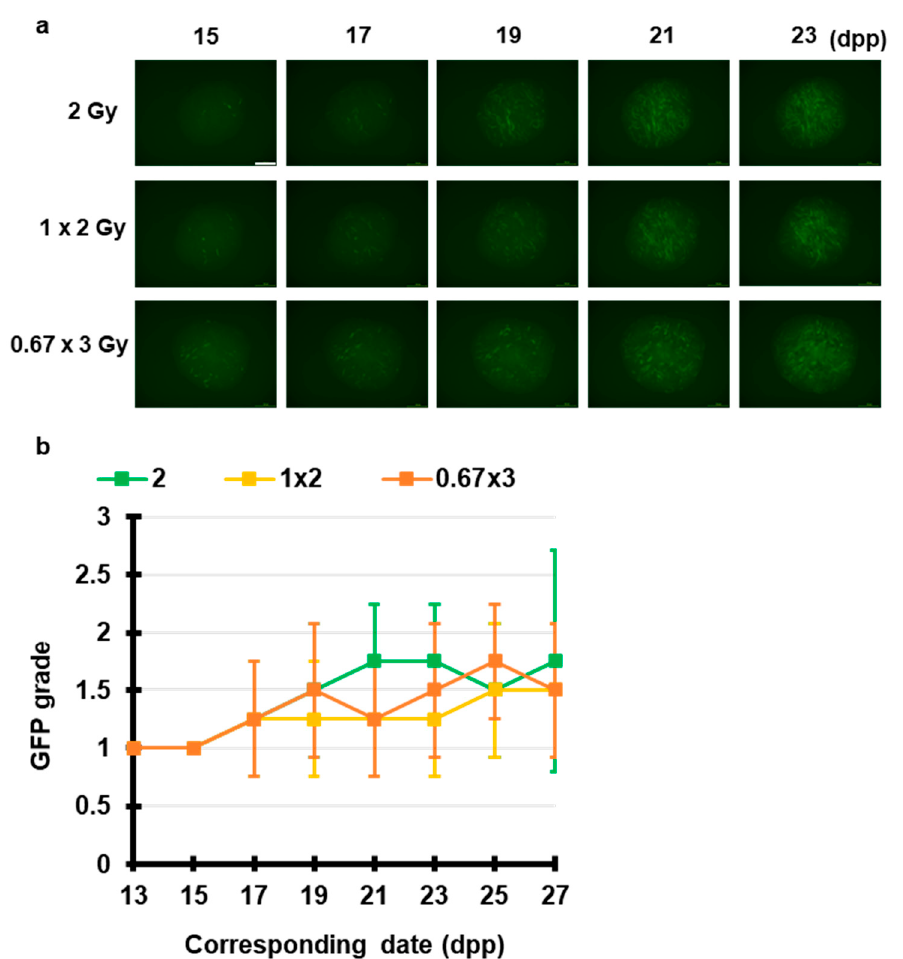
Figure 3. Chronological Acr-GFP expression changes after exposure to fractionated X-rays. ( a ) Representative images show Acr-GFP expression obtained at 15–23 dpp in single cultures following exposure to 2 Gy, 1 Gy × 2 (1 Gy per 24 h) and 0.67 Gy × 3 (0.67 Gy per 24 h) X-rays. Scale bar, 500 µ m. ( b ) Evaluation of Acr-GFP expression from 13 to 27 dpp. Single tissue samples from each mouse testes were randomly assigned to experimental groups. At least four tissue samples each from different donor mice were used for each experiment; contaminated samples were excluded. Data show the mean Acr-GFP expression ± SD. There was no statistically significant difference between group means.